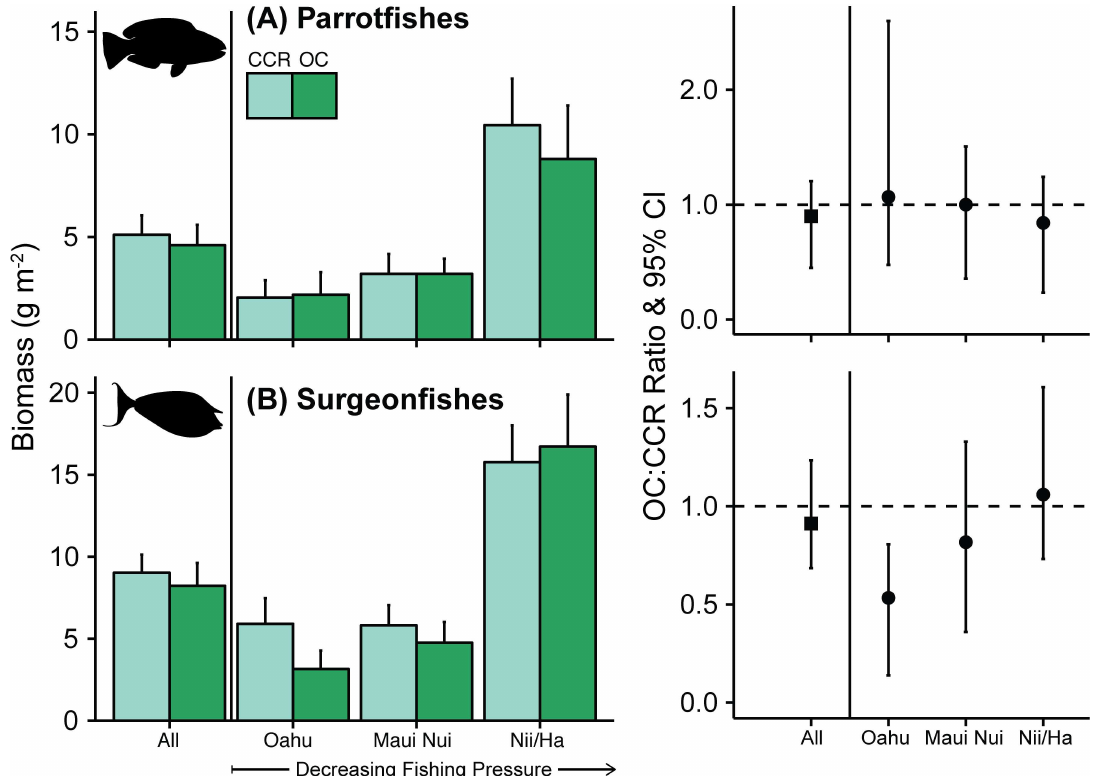
Fig 3. Biomass for target groups. Target fishes (cid:21) 20 cm TL (except A . triostegus and C . strigosus (cid:21) 15 cm). Biomass boxplotwith error bars indicating standard error for all sites and for Oahu, Maui Nui and Nii-Hama (Niihauand Hamakua coast). Locationgroups are orderedin direction of presumeddecliningspearfishing pressure from Oahu (highest) to Niihau- Hamakua (lowest). OC:CCR biomass ratio has 95% confidenceinterval for each location.